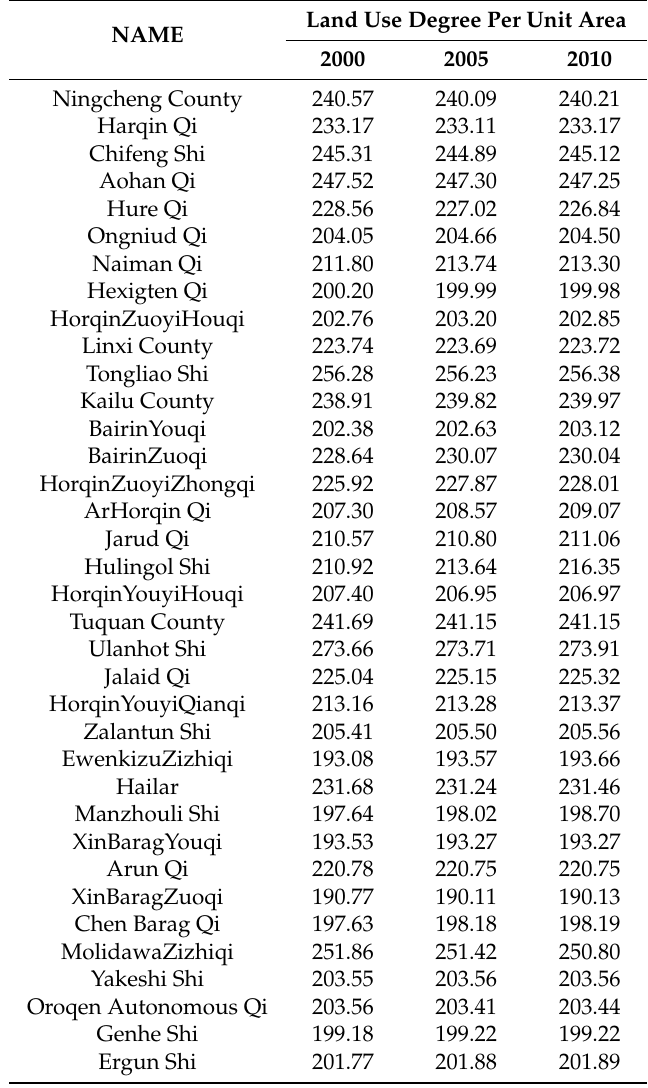
Table 7. Land use degree per unit area in administrative